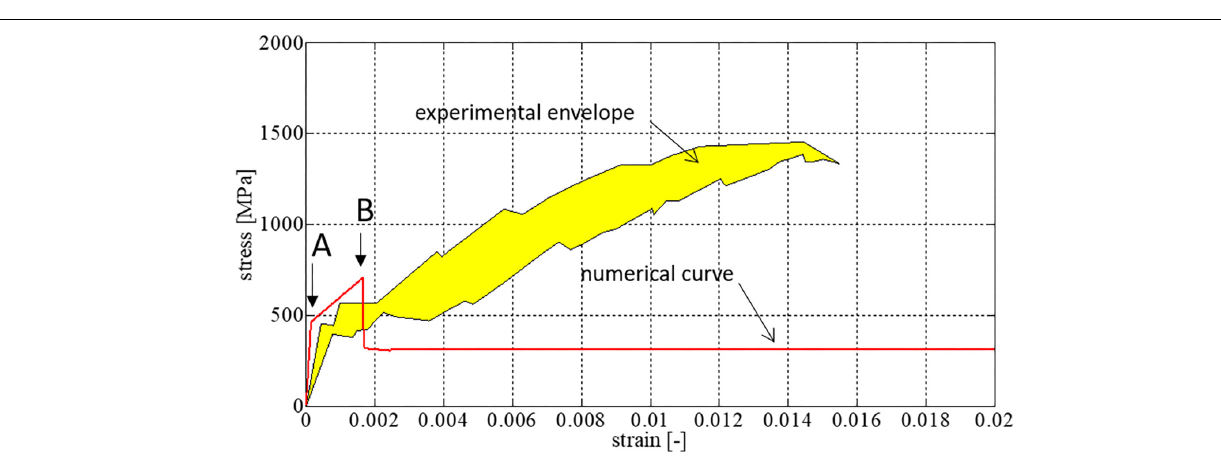
Frontiers in Built Environment |